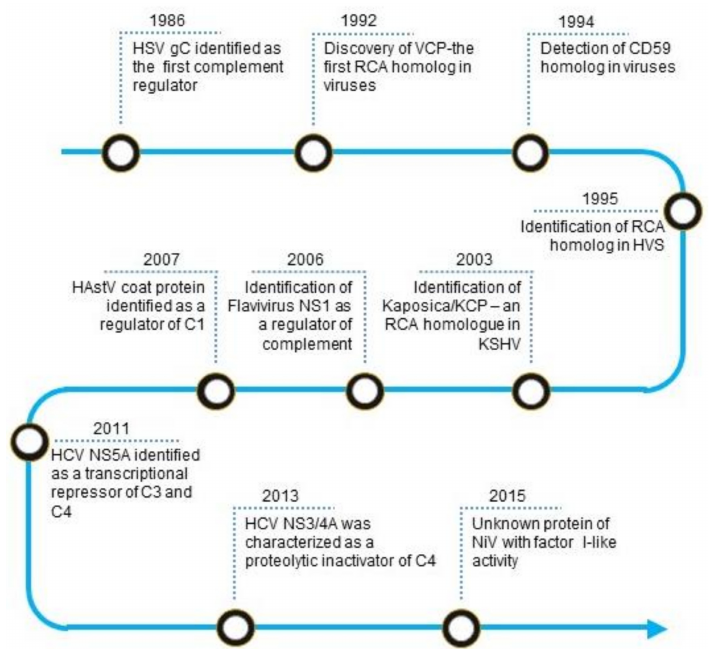
Figure 1. Timeline of identification of virally encoded complement regulators. Abbreviations: HSV gC, Herpes simplex virus glycoprotein C; VCP, Vaccinia virus complement control protein; RCA, regulator of complement activation; HVS, Herpesvirus saimiri; KSHV, Kaposi’s sarcoma-associated herpesvirus; Kaposica, KSHV inhibitor of complement activation; KCP, KSHV complement control protein; NS1, Non-structural protein; HAstV coat protein, Human astrovirus coat protein; HCV NS5A, Hepatitis C virus non-structural 5A protein; HCV NS3/4A, Hepatitis C virus non-structural 3/4A protease; NiV, Nipah